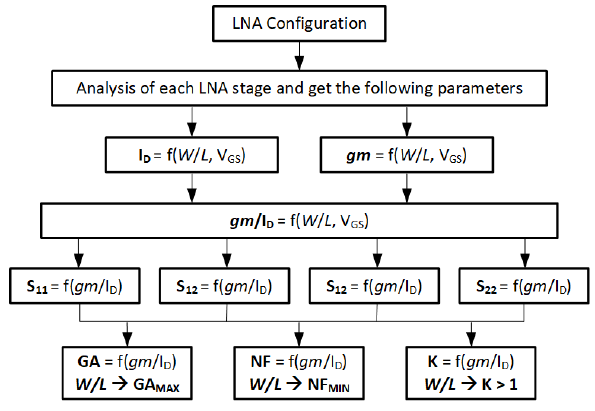
Figure 8. LNA stage characterization procedure.